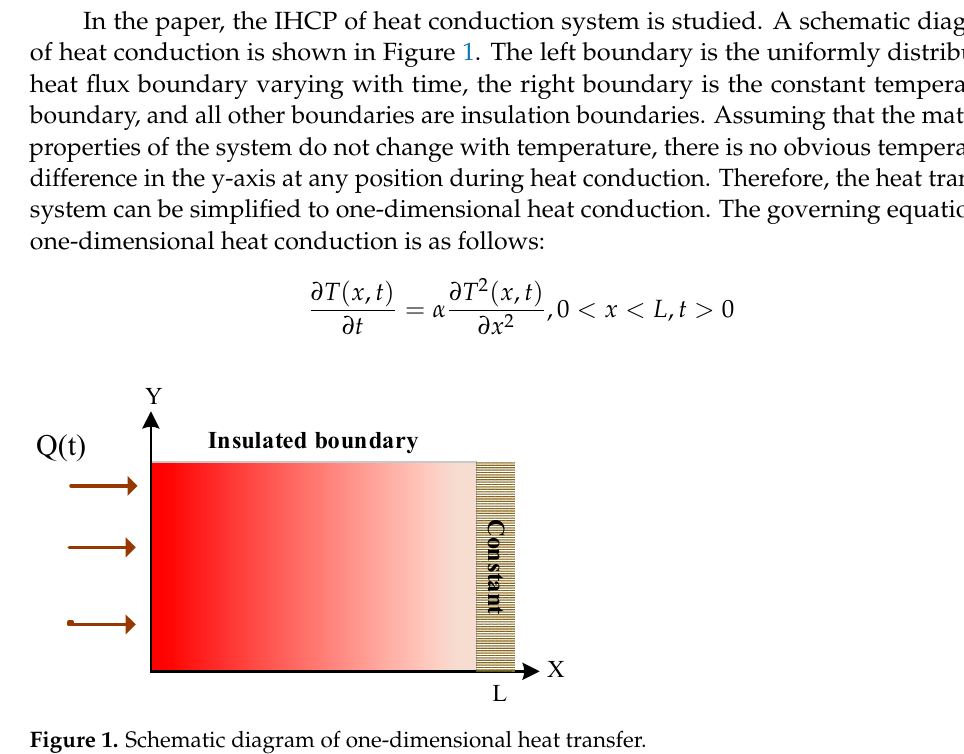
Figure 1. Schematic diagram of one-dimensional heat transfer.